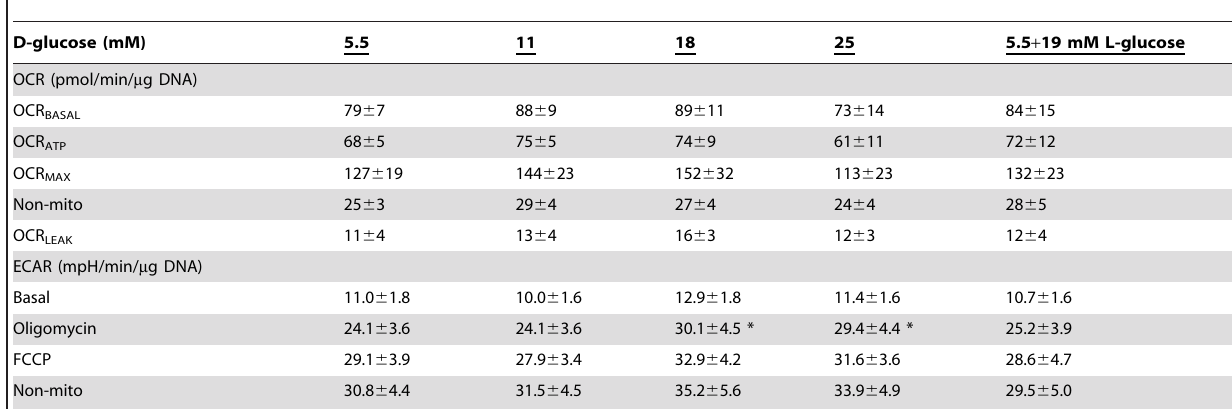
Table 1. Effect of chronic exposure to glucose on oxygen consumption rates (OCR) and extracellular acidification rates (ECAR) in BAE cells exposed to concentrations ranging from 5.5 to 25 mM for 18 h with these concentrations maintained during incubation in the extracellular flux